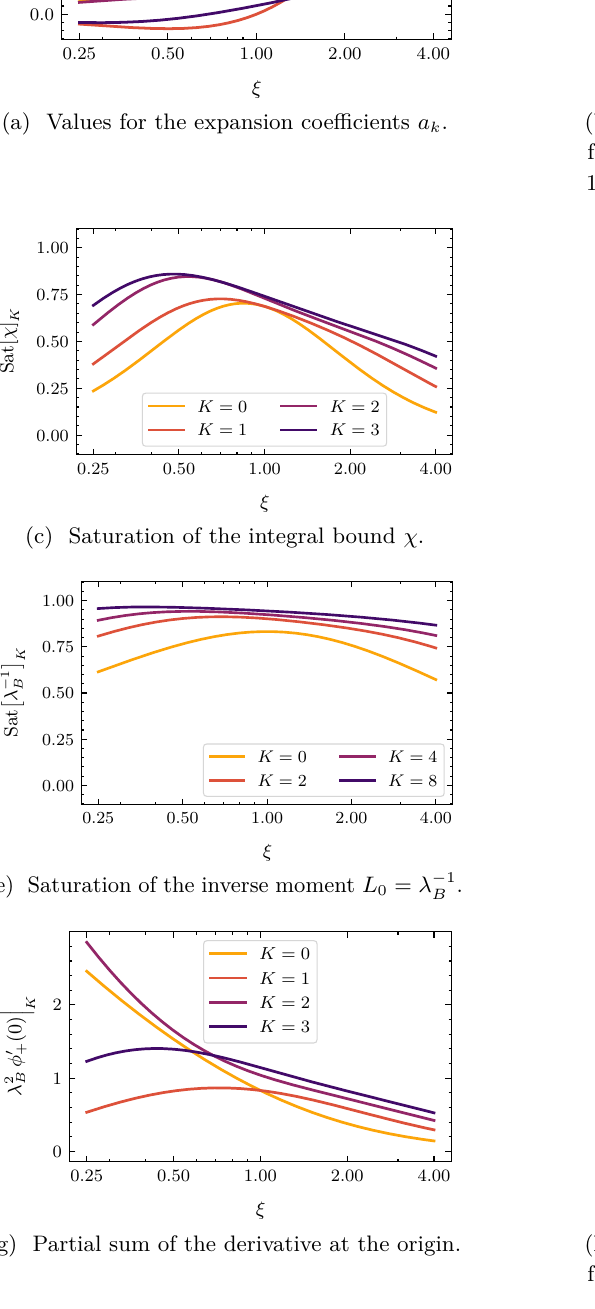
Figure 5 . Plots illustrating the truncation effects of our parametrization for the model eq. (4.22) discussed by Beneke et al. [10]. We often use the ratio ξ = ω